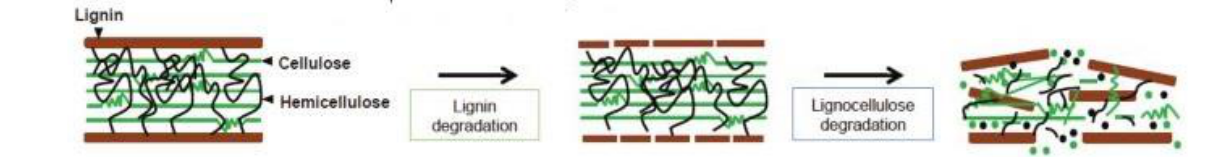
Figure 3. Lignin depolymerization with MnP [10].